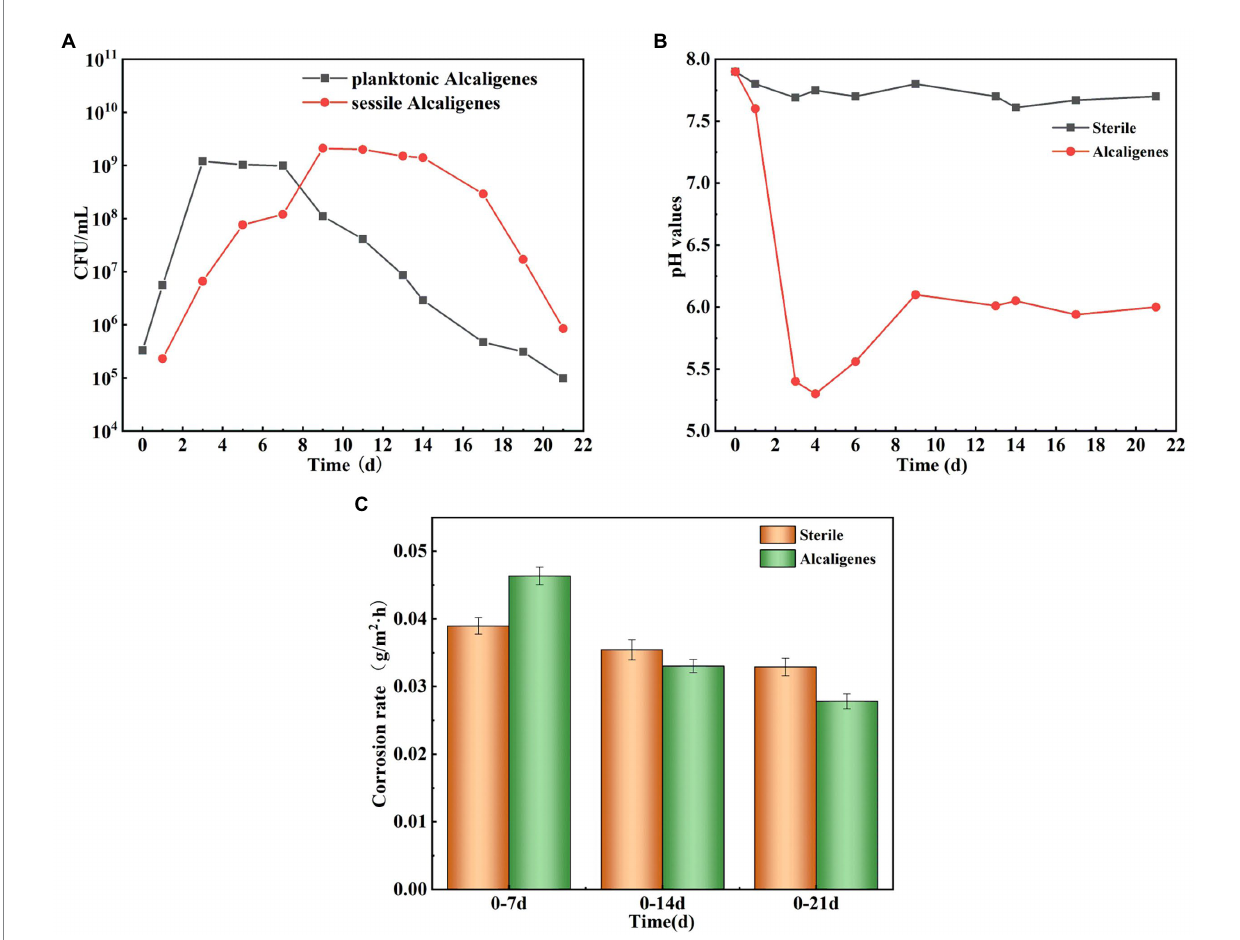
FIGURE 1 (A) Growth curves of Alcaligenes sp. in planktonic and sessile bacteria; (B) Trend of pH over time in sterile and Alcaligenes sp. media; (C) Average corrosion rate of X65 steel in sterile and Alcaligenes sp.